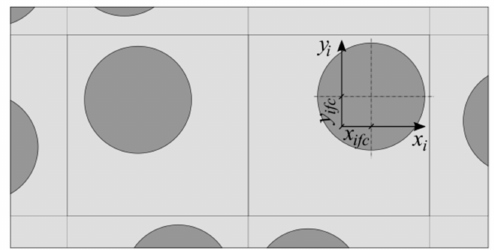
Figure 3. Repeatable volume element.